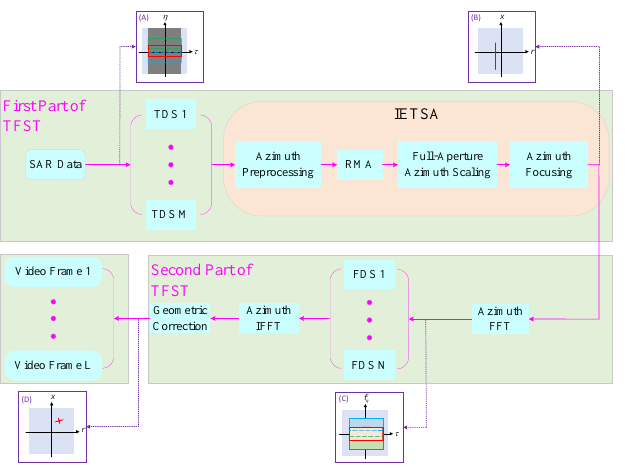
Figure 8. The complete flow diagram of high-resolution ViSAR data processing based on TFST. M and L are the total number of TDS and video frames, respectively, where L = M × N . N represents the number of FDSs generated by one TDS. This implies the assumption that the number of FDSs divided by each TDS is the same. The x and r in (B) represent the azimuth and range coordinates in the image domain, respectively.